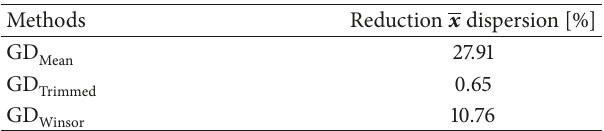
Table 49: Contaminated 𝜒 2 with 1000